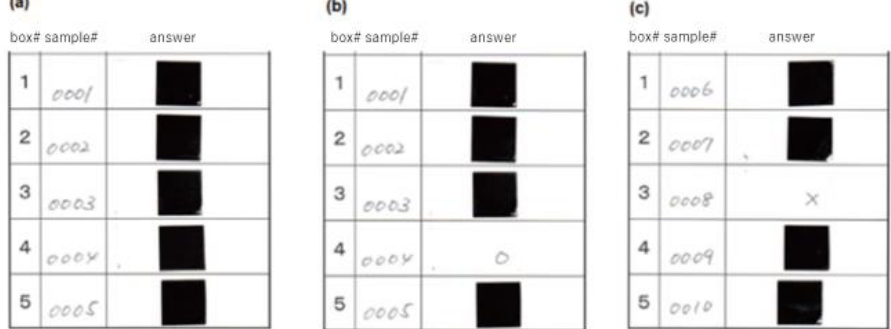
Figure 3. Answer Sheets used in the test. The test sample numbers and box numbers were shown on the answer sheet ( a ). The box number for the cancer sample was identified by an adjacent circle ( b ) and box numbers for the other samples were marked with an adjacent cross ( c ). The marks were then covered by a non-reattachable sticker. Examples of right ( b ) and wrong ( c ) answers are shown.